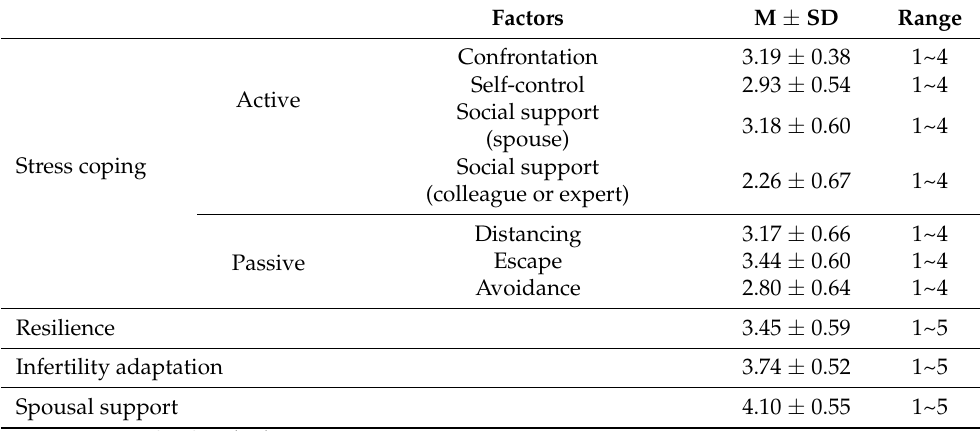
Table 2. Coping with infertility stress, resilience, infertility adaptation, and spouse support ( N = 120). Factors M ± SD Range Confrontation 3.19 ± 0.38 1~4 Self-control 2.93 ± 0.54 1~4 Active Social support 3.18 ± 0.60 1~4 (spouse) Stress coping Social support 2.26 ± 0.67 1~4 (colleague or expert) Distancing 3.17 ± 0.66 Escape 3.44 ± 0.60 Passive 2.80 ± 0.64 Resilience 3.45 ± 0.59 1~5 3.74 ± 0.52 4.10 ±